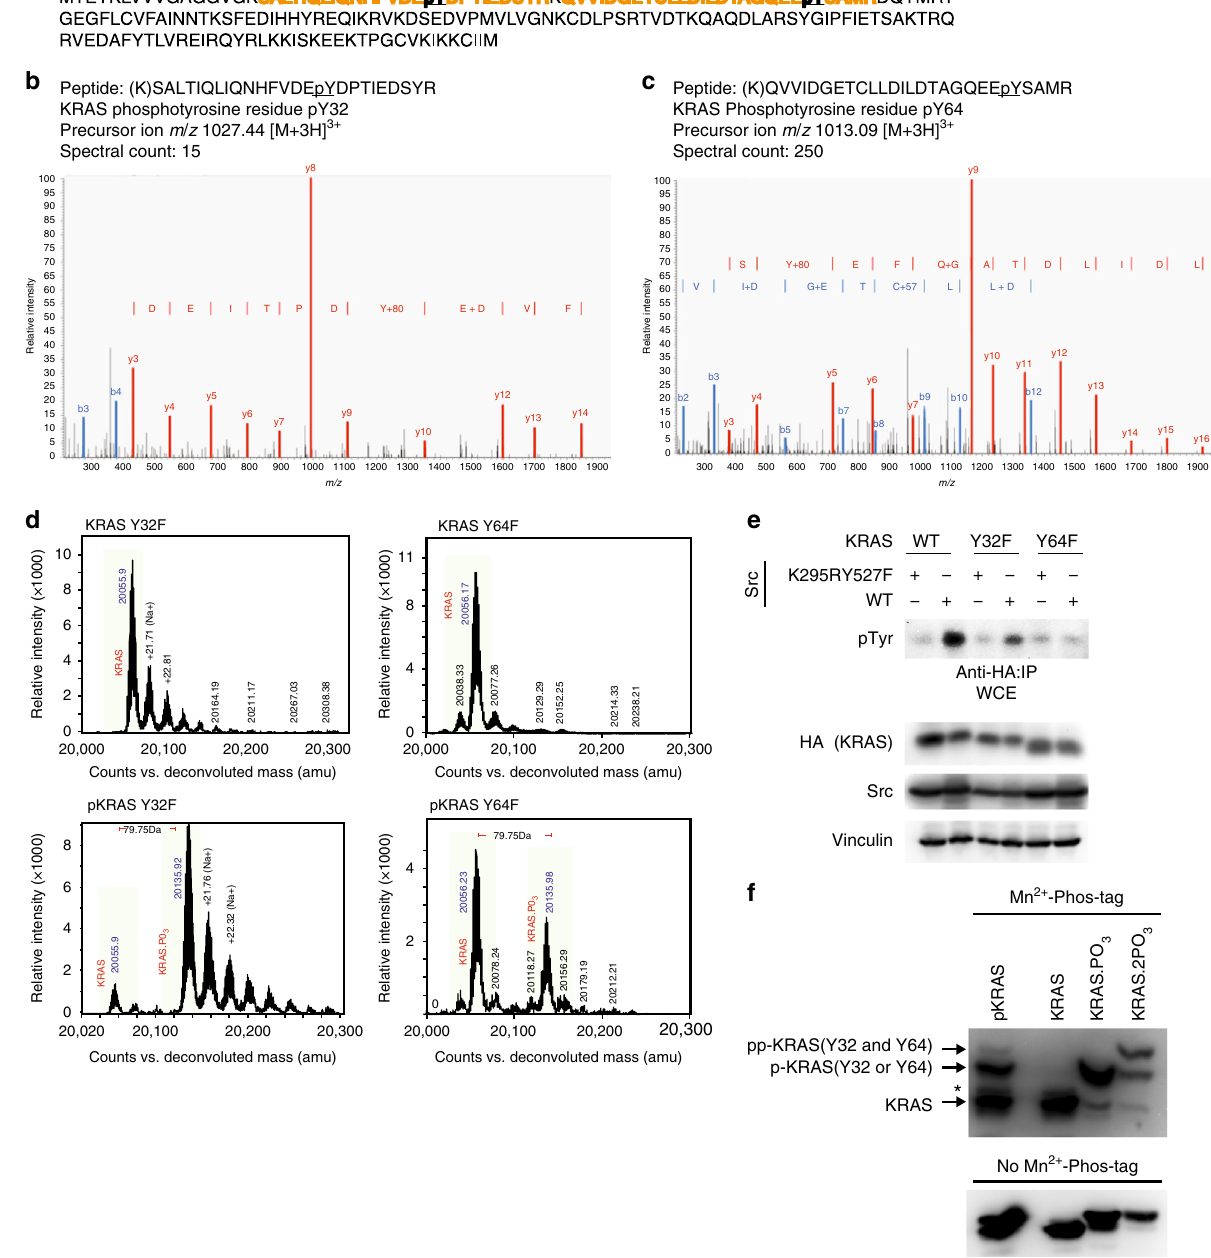
Fig. 2 Src phosphorylates KRAS tyrosine 32 and 64. a – c Two phosphorylated tyrosine residues from the KRAS protein sequence ( a ) were identi fi ed from in vitro kinase reaction samples that were reduced/alkylated, trypsin-digested, and analyzed by LC-MS. MS/MS spectra matched indicated KRAS tryptic peptides containing residue Y32 ( b ) and Y64 ( c ). d Upper panel: Mass spectra of unmodi fi ed KRAS Y32F (left) and KRAS Y64F (right). Lower panel: Mass spectrum of pKRAS Y32F (left) and pKRAS Y64F (right). The major peak of KRAS is shaded light green. e HEK293 cells were transfected with the indicated plasmids. Cells were lysed, immunoprecipitated, and immunoblotted with the indicated antibodies. The immunoblot data are representative of at least three separate experiments. f GTP-bound KRAS were subjected to in vitro kinase assay using puri fi ed Src kinase (left lane) and were separated into un- phosphorylated (KRAS), mono-phosphorylated (KRAS.PO 3 ), and di-phosphorylated (KRAS.2PO 3 ) forms by anion exchange chromatography. These samples were then analyzed by 50 μ M Mn 2 + -PhosTag SDS-PAGE (upper panel) or conventional SDS-PAGE (lower panel) and immunoblotted with anti- RAS antibody. Asterisk indicates non-speci fi c band. IP immunoprecipitation, WCE whole-cell extract. The immunoblot data are representative of at least three independent